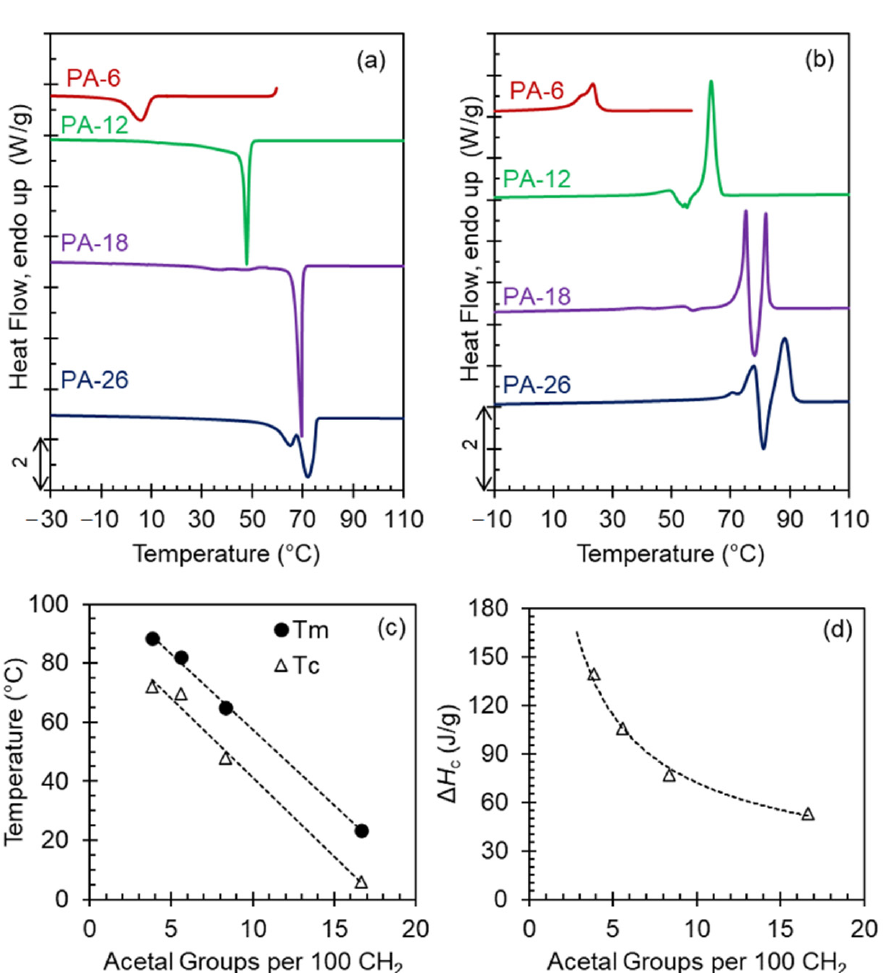
Figure 1. Cooling exotherms ( a ) and subsequent melting endotherms ( b ) of even polyacetals collected by differential scanning calorimetry (DSC) at 10 ° C/min. Data have been vertically shifted for clarity. ( c ) Highest peak crystallization (open triangles) and melting (filled circles) temperatures, and ( d ) heat of crystallization as a function of the number of acetal groups per 100 methylene groups in the aliphatic spacer.